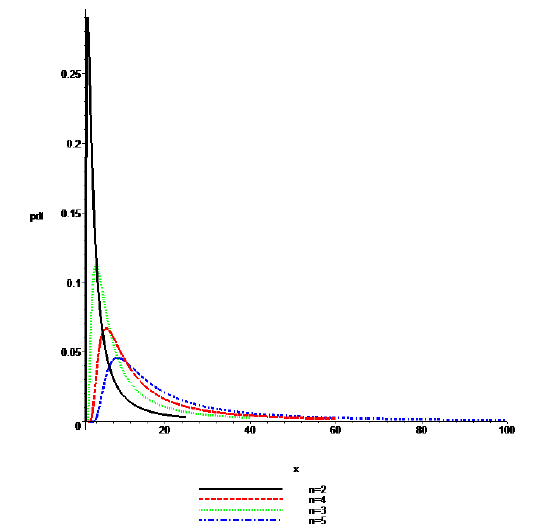
Figure 1: Plots of the pdf (2.1) for n = 2, 3, 4,